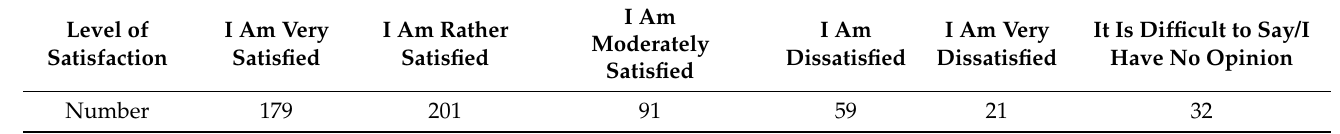
Table 1. Overall rating of satisfaction with life in the